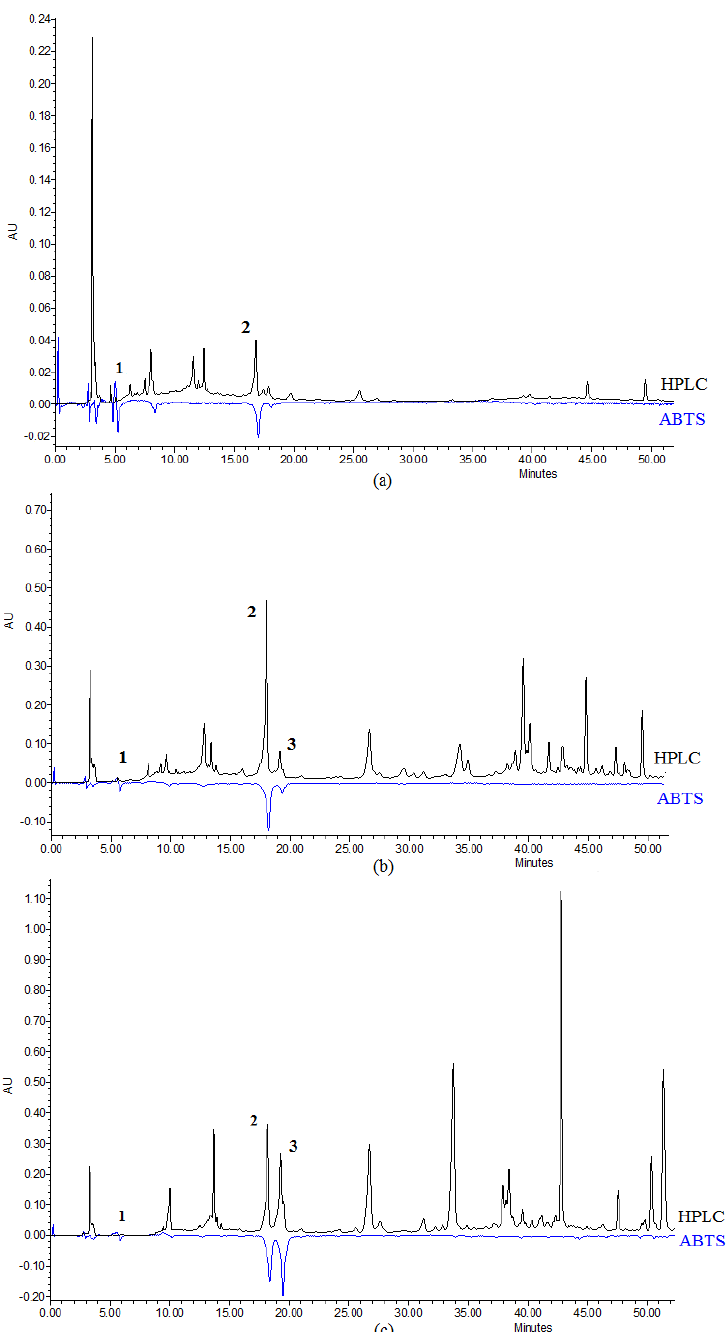
Figure 4. HPLC-ABTS chromatograms of ( a ) I. variegata rhizomes extract (H 2 O) at 247 nm (HPLC, black) and 650 nm (ABTS, blue); ( b ) I. hungarica rhizomes extract (H 2 O) at 255 nm / 650 nm, and ( c ) I. hungarica rhizomes extract (70% EtOH) at 314 nm / 650 nm. Gallic acid ( 1 ), mangiferin ( 2 ), and caffeic acid ( 3 ).